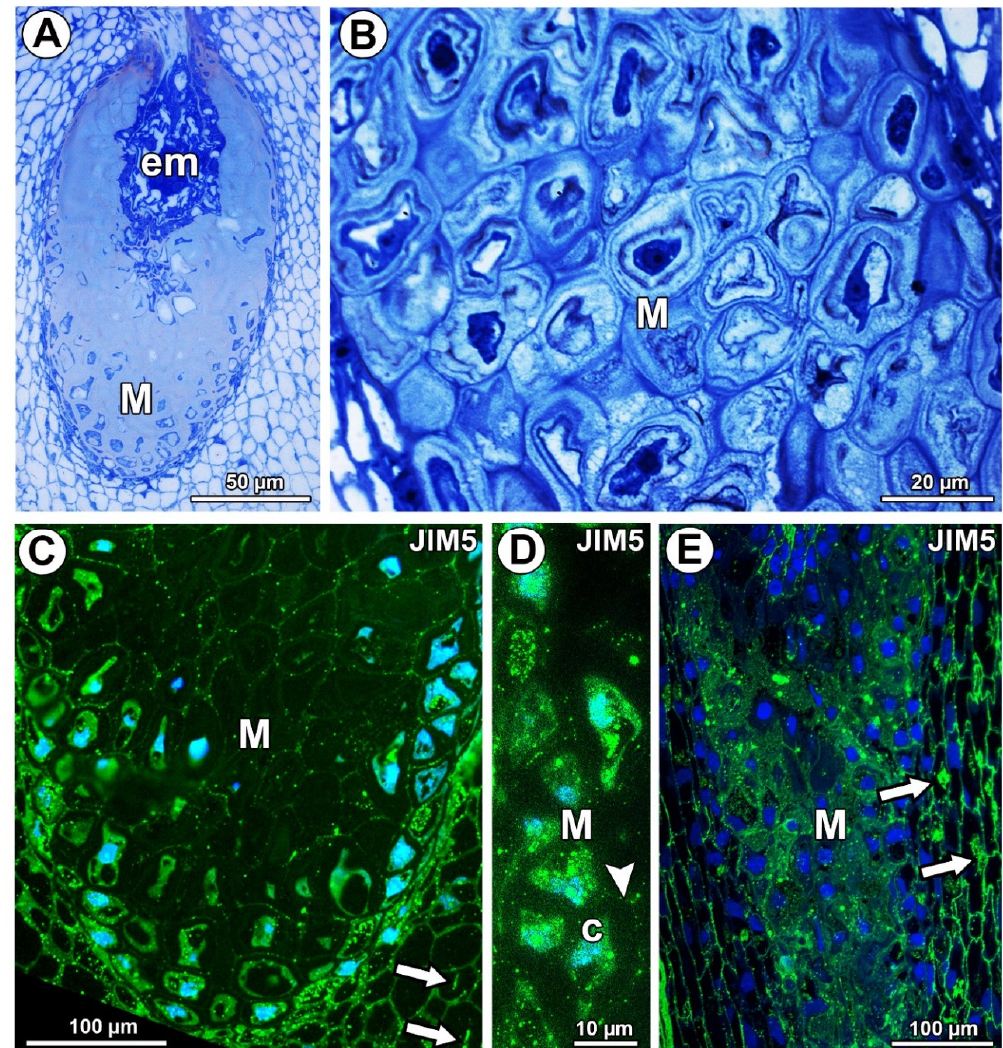
Figure 1. Histology and pectin (JIM5) detection. ( A ) Section through the young seed of Taraxacum o ffi cinale ; note the presence of embryo (em) and mucilage cells (M). ( B ) Mucilage cells (M) stained with metachromatic dye toluidine blue O in an ovule of T. o ffi cinale . ( C ) Pectin (JIM5) detection in mucilage cells of integument periendothelial tissue in an ovule of T. o ffi cinale . ( D ) Pectin (JIM5) detection in mucilage cells (M); note the intense signal in the cytoplasm of mucilage cells (c) and in the cell wall (arrowhead) in an ovule of T. officinale . ( E ) Pectin (JIM5) detection in the ovule of Pilosella officinarum ; mucilage cells of integument periendothelial tissue (M).